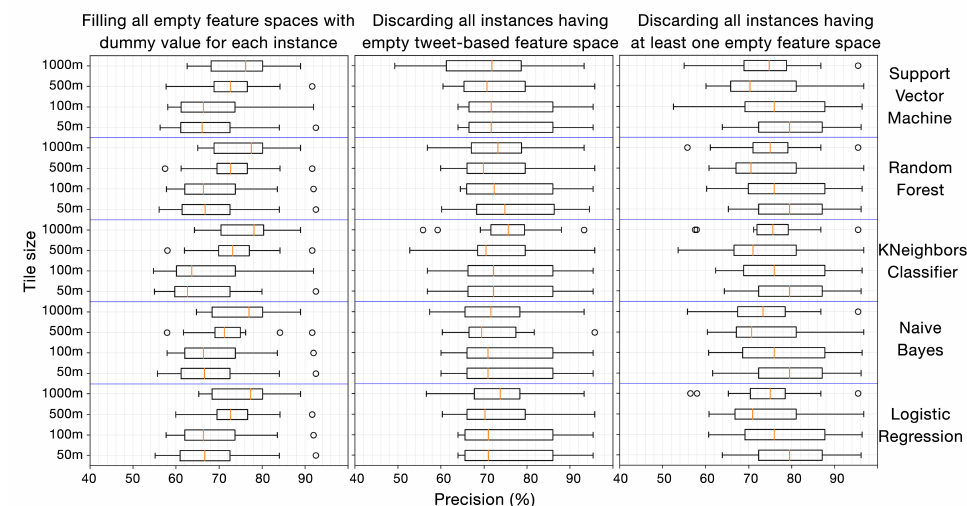
Figure 8. Comparison of the precision of five classification algorithms for different tile sizes. The three plots represent different datasets based on how empty cells were handled using the dummy value. The variability in the boxplots is due to the different precisions for the individual cities.